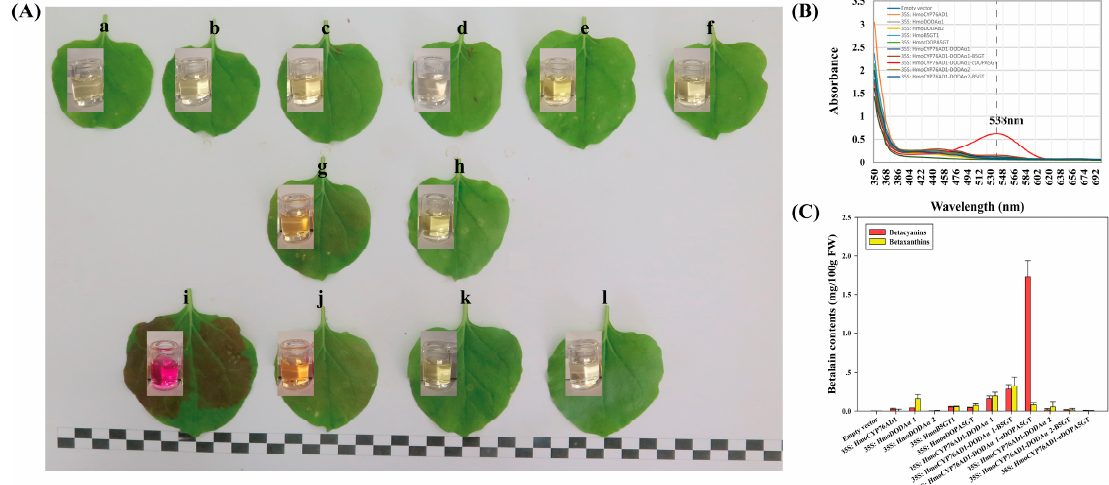
Figure 8. Transient expression of candidate genes in N. benthamiana . ( A ) Phenotype and extract of N. benthamiana leaves after infected. ( a – f ) Empty vector, HmoCYP76AD1 , HmoDODA α 1 , HmoDODA α 2 , HmoB5GT1 , HmocDOPA5GT ; ( g , h ) HmoCYP76AD1 - HmoDODA α 1 , HmoCYP76AD1 - HmoDODA α 2 ; ( i – l ) HmoCYP76AD1 - HmoDODA α 1 - HmocDOPA5GT , HmoCYP76AD1 - HmoDODA α 1 - HmoB5GT1 , HmoCYP76AD1 - HmoDODA α 2 - HmoB5GT1 , HmoCYP76AD1 - HmoDODA α 2 - HmocDOPA5GT ; ( B ) Maximum absorption of the pigment. ( C ) Betalain contents in N. benthamiana leaves. Scale bars = 1